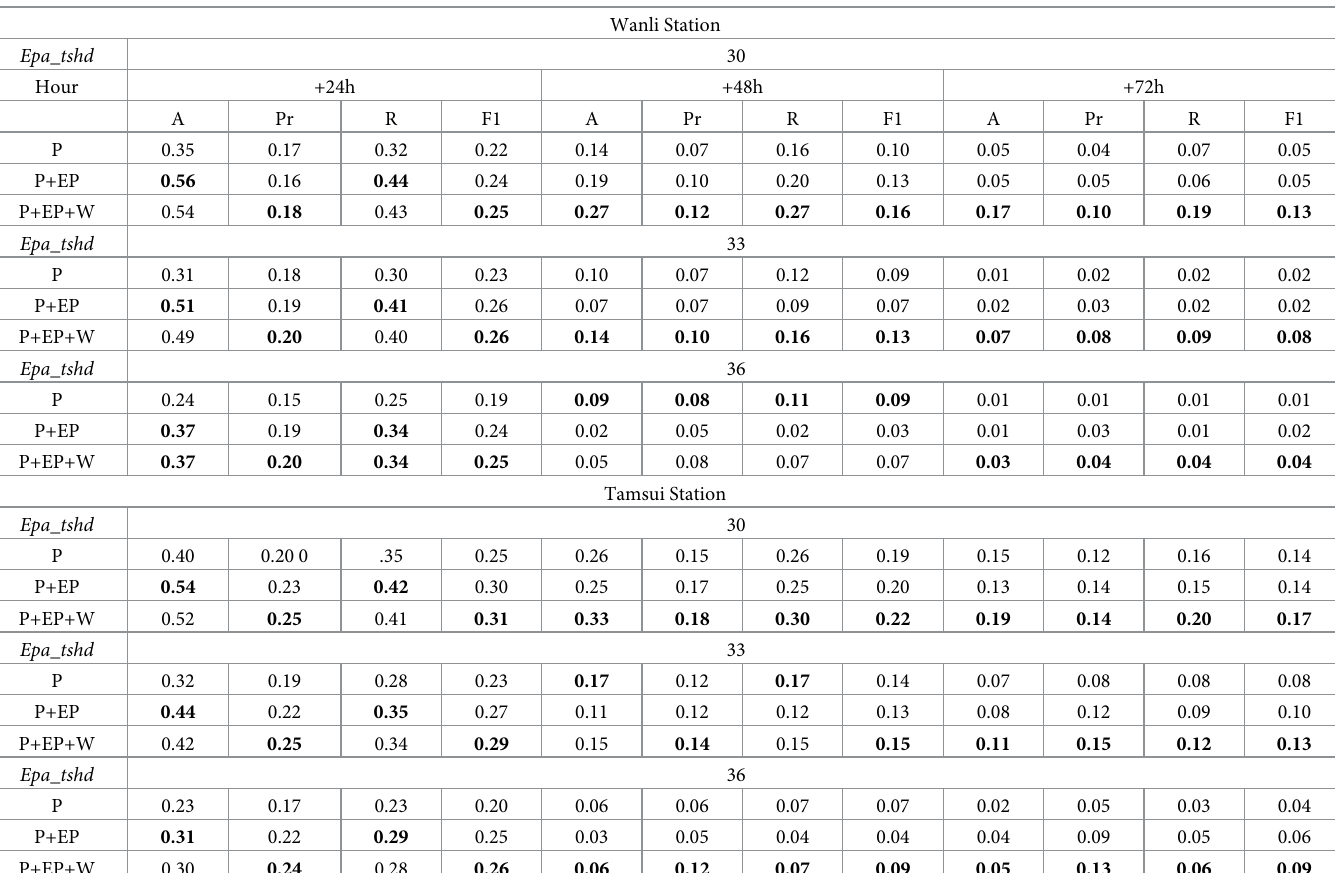
Table 4. Classification results with Diff_tshd = 1.0 .